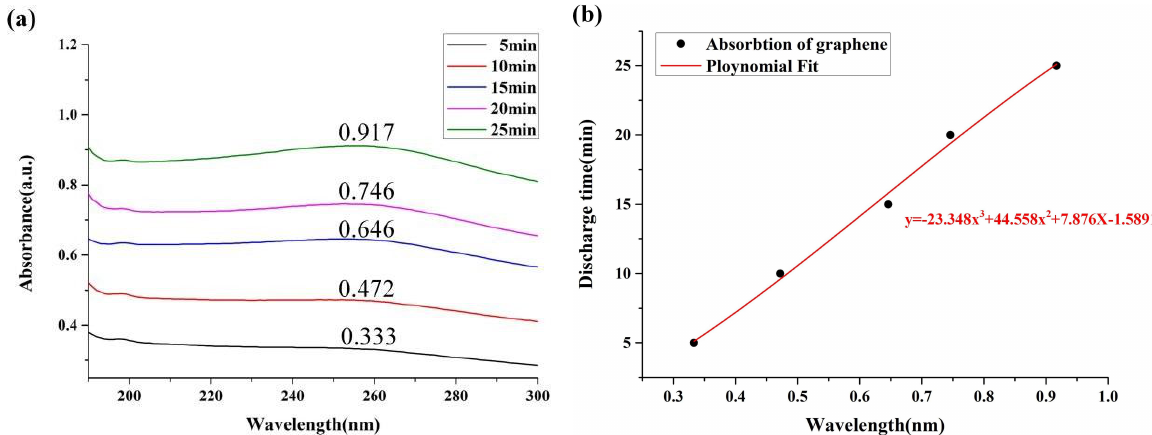
Figure 11: Different discharge time of graphene (a) UV-Vis; (b) Eq. (2)